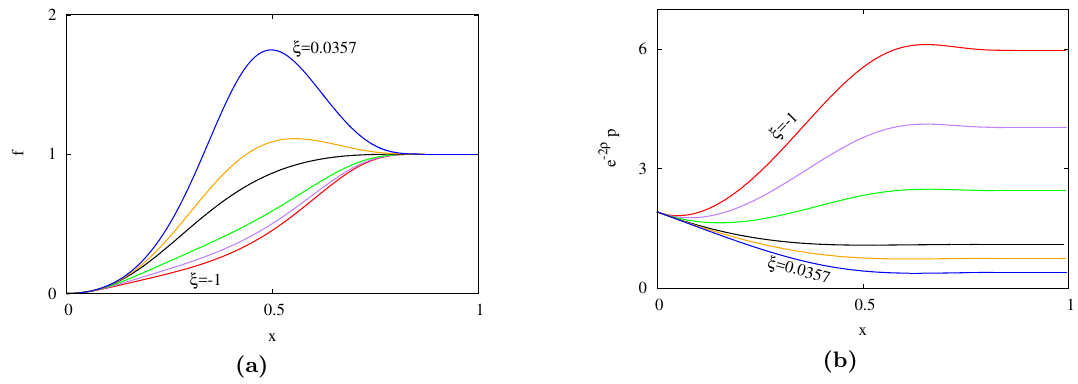
Figure 11. (a) Similar pro(cid:12)les for the function f and (b) the rescaled function p in terms of the compacti(cid:12)ed radial coordinate x = (cid:26)= ( (cid:26) + 1).